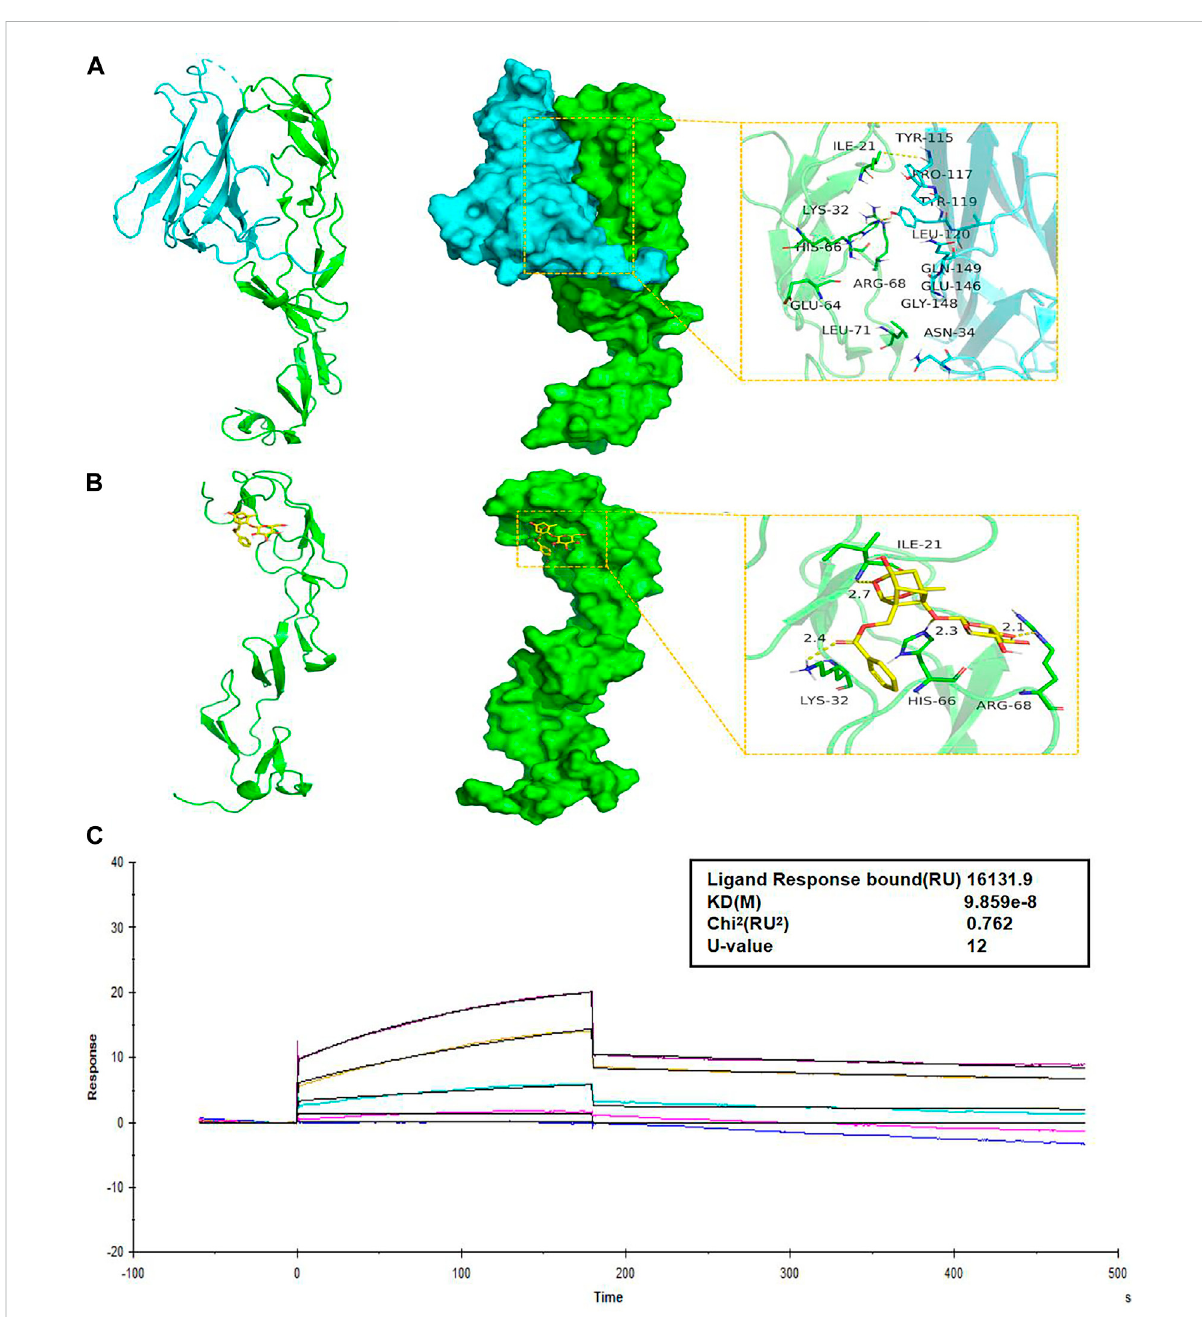
FIGURE 9 PF directly binds to TNFR1. (A) The binding mode of the complex TNFRSF1A with TNF. The backbone of protein was rendered in a tube and coloredingreen.TNFRSF1A(left)andTNF(right)proteinwererenderedbythesurface.Theyellowdashrepresentsahydrogenbondorsaltbridge. (B) The binding mode of the complex TNFRSF1A with PF. The backbone of protein was rendered in a tube and colored in green. TNFRSF1A protein was rendered by the surface. The yellow dash represents a hydrogen bond or salt bridge. (C) SPR assay showed the steady-state fi t of binding between PFandTNFR1.TNFR1,tumornecrosisfactorreceptor1;TNFRSF1A,tumornecrosisfactorreceptorsuperfamilymember1;PF,paeoni fl orin; SPR, surface plasmon